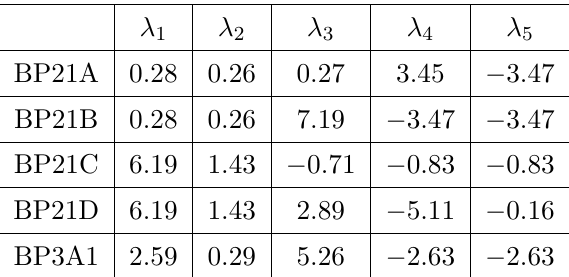
Table 2. Higgs self-couplings for the 2HDM benchmark points in the alignment limit. We omit the imaginary parts appearing in the CMS.